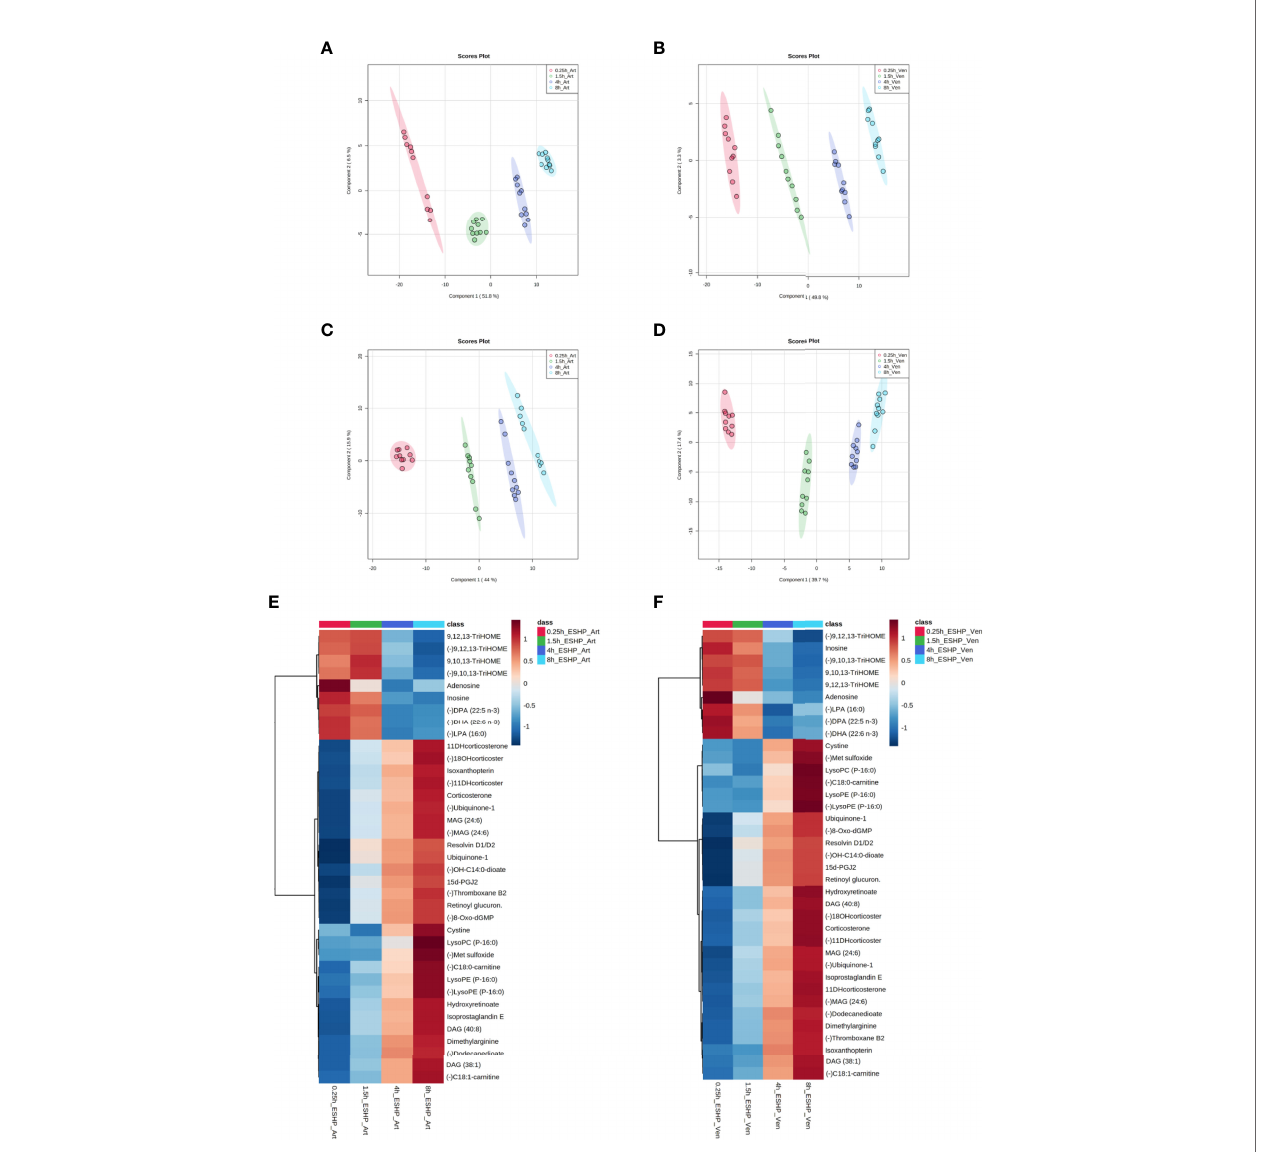
FIGURE 5 | Metabolic alterations in perfusate samples during porcine ESHP. PLS-DA score plots depicting changes in metabolomic patterns throughout ex situ heart perfusion at the time of perfusate sampling (A – D) , and color-coded maps illustrating the average abundance of the most altered metabolic features when the 8 h sampling time-point was compared against the 15 min, 1.5 h, and 4 h time points (E, F) . The models were created for metabolic features detected in ESI+ (A, B) and ESI- (C, D) / PFP-based mode. Red — arterial/venous perfusate samples taken at 15 min of ESHP; green — arterial/venous perfusate samples taken at 1.5 h of ESHP; dark blue — arterial/ venous perfusate samples taken at 4 h of ESHP; light blue — arterial/venous perfusate samples taken at 8 h of ESHP. The predictive ability of the generated models (during PLS-DA analysis) was veri fi ed via LOOCV, and strong predictive performance was con fi rmed, with Q2~0.9 (for 5-component cross-validation: 0.997 and 0.998 for ESI+/Art and ESI+/Ven samples, respectively, and 0.998 and 0.997 for ESI-/Art and ESI-/Ven samples, respectively). (E, F) Heat maps of metabolomic differences between perfusate samples taken at various time points during ESHP. ( – ) refers to negative ionization mode. TriHOME – Trihydroxyoctadecenoic acid; DPA (22:5 n-3) – Docosapentaenoic acid; DHA (22:6 n-3) – Docosahexaenoic acid; 11-DHcorticosterone – 11-Dehydrocorticosterone; 18-OHcorticosterone – 18-Hydroxycortico-sterone; OH-C14:0-dioate – 3- Hydroxytetradecanedioic acid; 15d-PGJ2 – 15-Deoxy-d-12,14-PGJ2; C18:0-carnitine – Stearoylcarnitine; C18:1-carnitine –